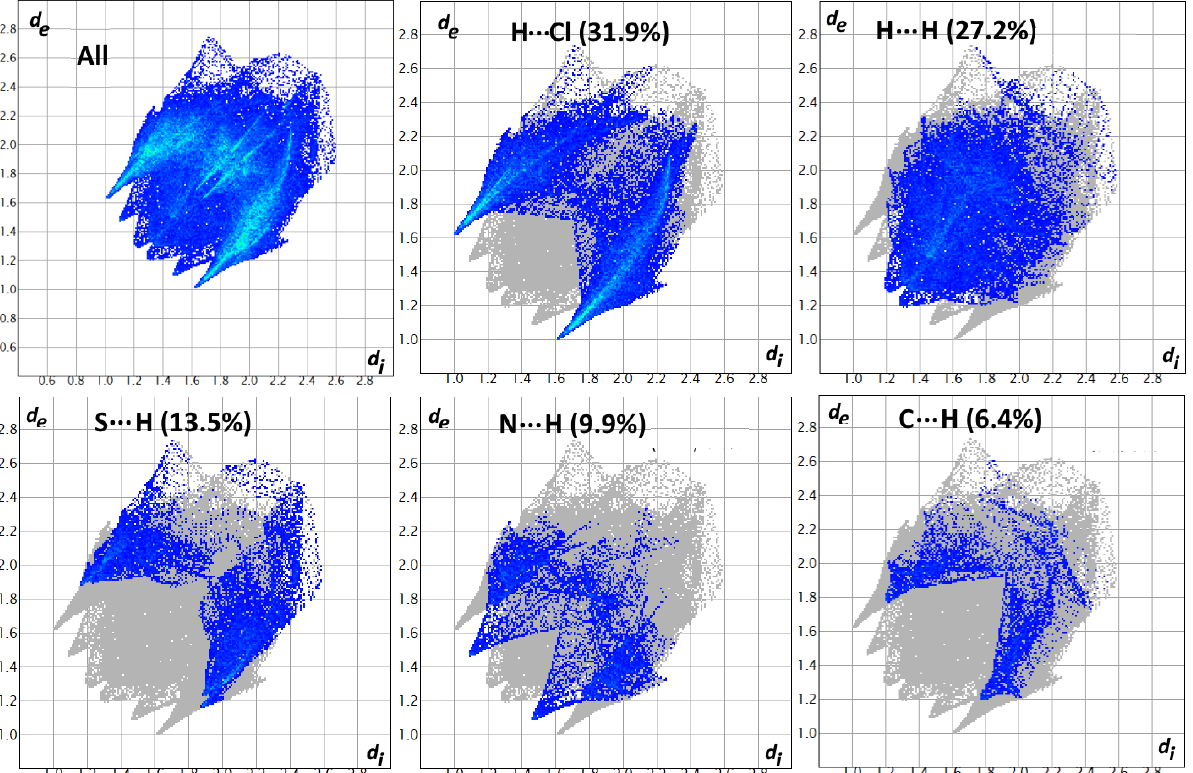
Figure 5. Fingerprint plots for the copper complex, showing percentages of important contact contributions to the total Hirshfeld surface area of the copper molecule.